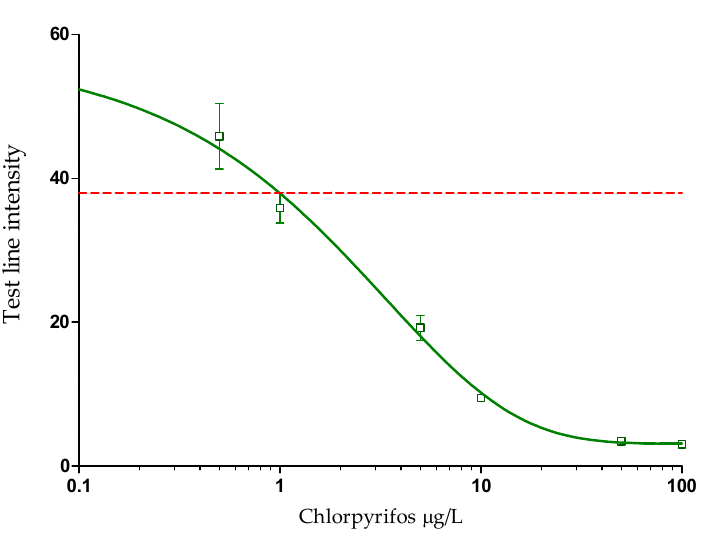
Figure 3. Dose–response curve constructed by four-parameter logistic regression, based on Cube readings ( n = 2) of calibration standards ( n = 3) in the CHLP LFIAs, performed in three independent experiments within one day with a two hour interval between each experiment, displayed as average test line intensities ( n = 6). The calculated limit of detection is indicated by the red dotted line. inhibitory concentration (IC 50 ) of 1.97 µ g/L. The limit of detection (LOD) was